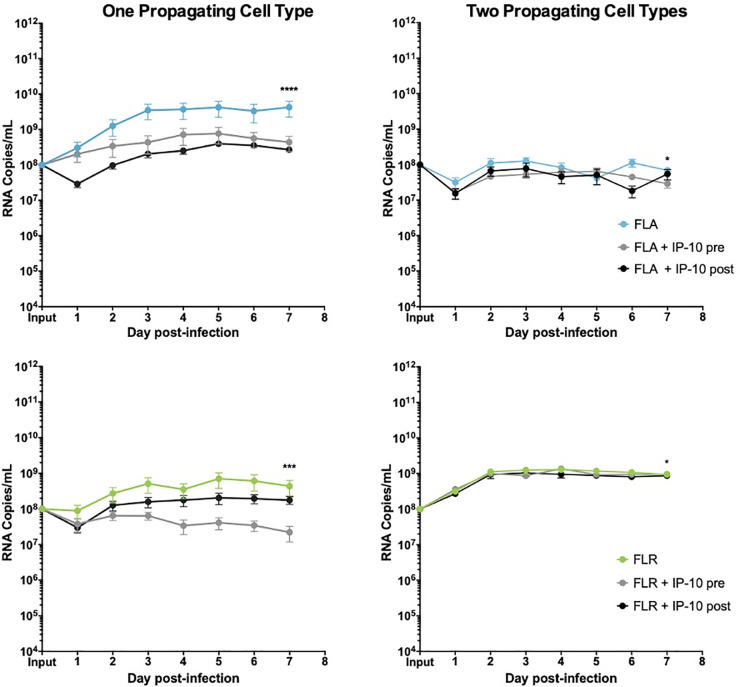
IP-10 treatment decreases ZIKV replication in low passage ZIKV infection of prostate epithelial cells.PNT1a epithelial cells were treated for 3 hours with 3.75 ng/mL human IP-10 prior to infection (pre), or 24 hours after infection (post). Cells were infected with ZIKV FLA or FLR propagated in only one cell type (left column), or after passage through two cell types (right column). Infected cell supernatants were collected and RNA extracted daily up to 7dpi. One-step qRT-PCR was performed with ZIKV specific primer and probe to assess viral replication. Data are from 2 or 3 independent experiments with 3 technical replicates each. Error bars are SEM. Statistical significance was determined using D'Agostino & Pearson omnibus normality test, and a repeated measures two-way ANOVA with multiple comparison t-tests using the Holm-Sidak correction. Significance was * = p<0.05; *** = p<0.005; **** = p<0.001, comparing differences in overall virus replication between treatment conditions.